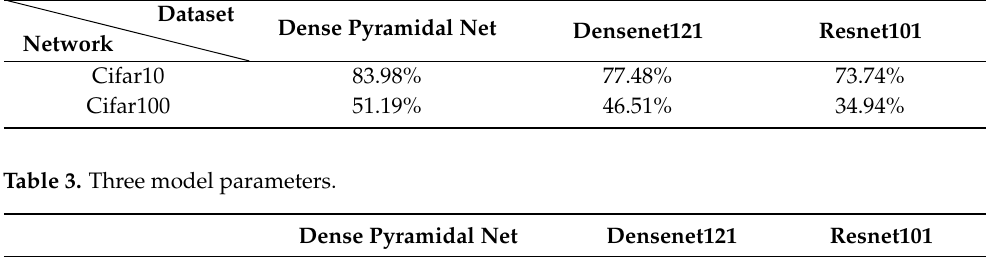
Table 2. Accuracy of the three algorithms on two datasets.